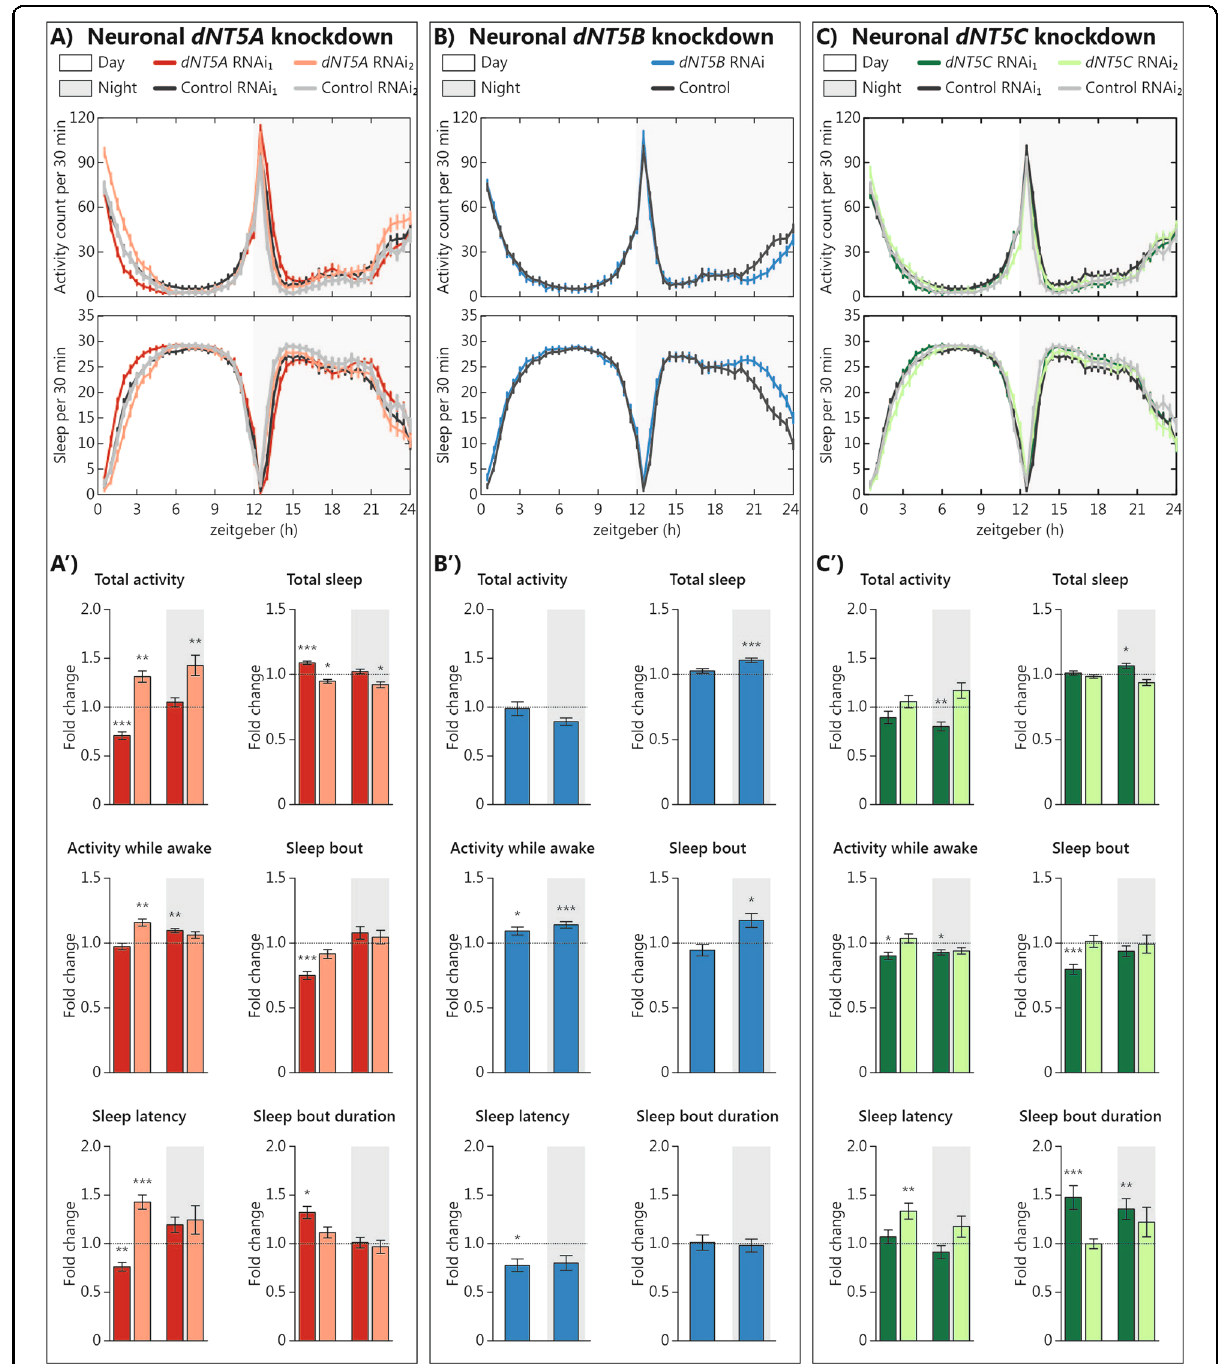
Fig. 3 Neuronal manipulation dNT5A , dNT5B , and dNT5C only slightly affected activity and sleep. A – C Activity and sleep plot of pan-neural manipulation of A dNT5A (RNAi 1 : w , UAS - Dcr2 ;; nSyb - Gal4 / UAS - dNT5A RNAi 1 , n = 84; RNAi 2 : w , UAS - Dcr2 ; UAS - dNT5A RNAi 2 ; nSyb - Gal4 , n = 77), B dNT5B ( w , UAS - Dcr2 ;; nSyb - Gal4 / UAS - dNT5B RNAi , n = 71), and C dNT5C (RNAi 1 : w , UAS - Dcr2 ;; nSyb - Gal4 / UAS - dNT5C RNAi 1 , n = 86; RNAi 2 : w , UAS - Dcr2 ; UAS - dNT5C RNAi 2 ; nSyb - Gal4 , n = 61). All genotypes were tested together. Genetic background controls for dNT5A , dNT5B , and dNT5C RNAi 1 as well as for dNT5A and dNT5C RNAi 2 are identical, respectively, and re-plotted across panels for convenience. A ′ , B ′ , C ′ Quanti fi cation of activity and sleep parameters, normalized to respective control (RNAi 1 : w , UAS - Dcr2 ;; nSyb - Gal4 / + , n = 88; RNAi 2 : w , UAS - Dcr2 ; + ; nSyb - Gal4 , n = 62). Error bars represent standard error of the mean. One-way analysis of variance (ANOVA) followed by Dunnett ’ s post-hoc test was used to obtain an adjusted p -value ( p adj ) (* p adj < 0.05, ** p adj < 0.01, *** p adj < 0.001). N = 3 biological replicates, minimum 20 fl